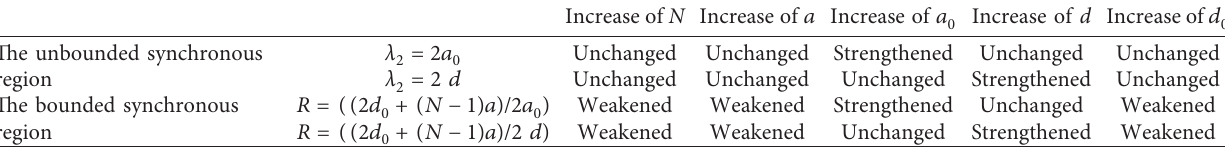
,d, and d of Network II when N is odd. 0 0